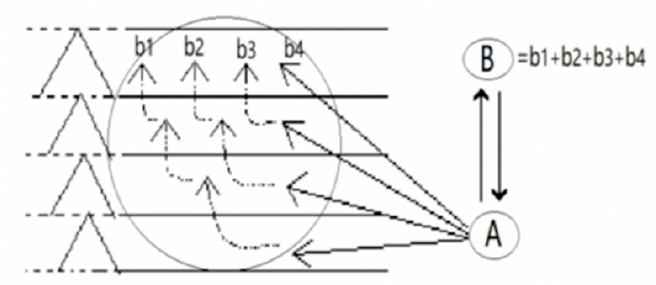
Figure 4. Physical interactions are encoded by the hierarchical construction of the system.